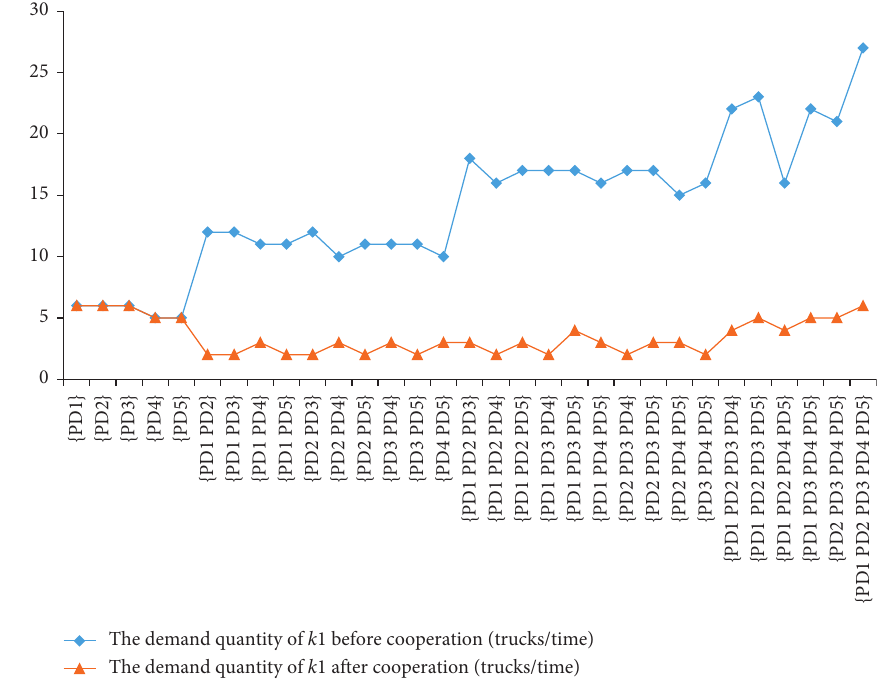
Figure 7: Comparison between initial and optimized networks k 1 usage solutions.